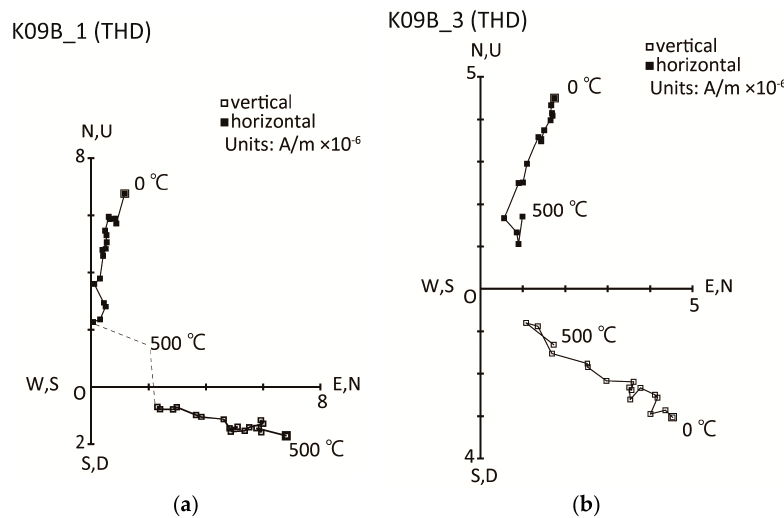
Figure A1. Vector plots for successive thermal demagnetization steps for 1-inch core samples from K09 ( Porites colony): ( a ) K09B_1; ( b ) K09B_3. U — up; D — down. All measurements were conducted using a conventional spinner magnetometer (Aspin; Natsuhara Giken Co. Ltd., Osaka, Japan) with a sensitivity of 5 × 10 − 9 A/m.